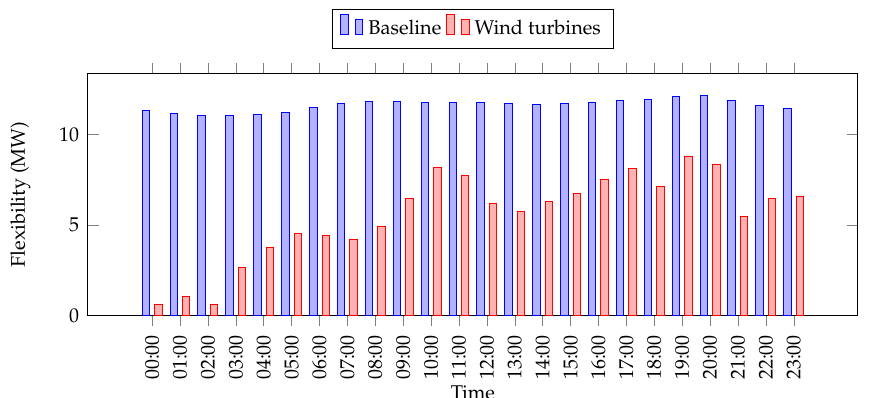
Figure 16. Activate-able flexibility volume with and without additional wind